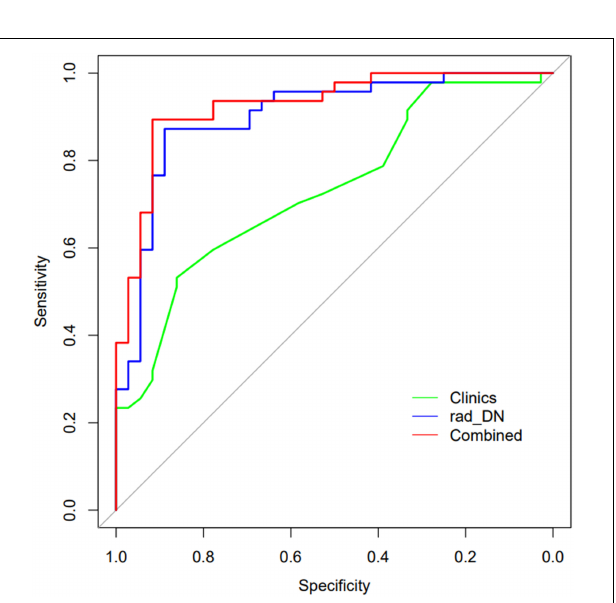
FIGURE 5 | The ROCs of the demographic information-only model, radiomics-only model of DN, and the combined model are